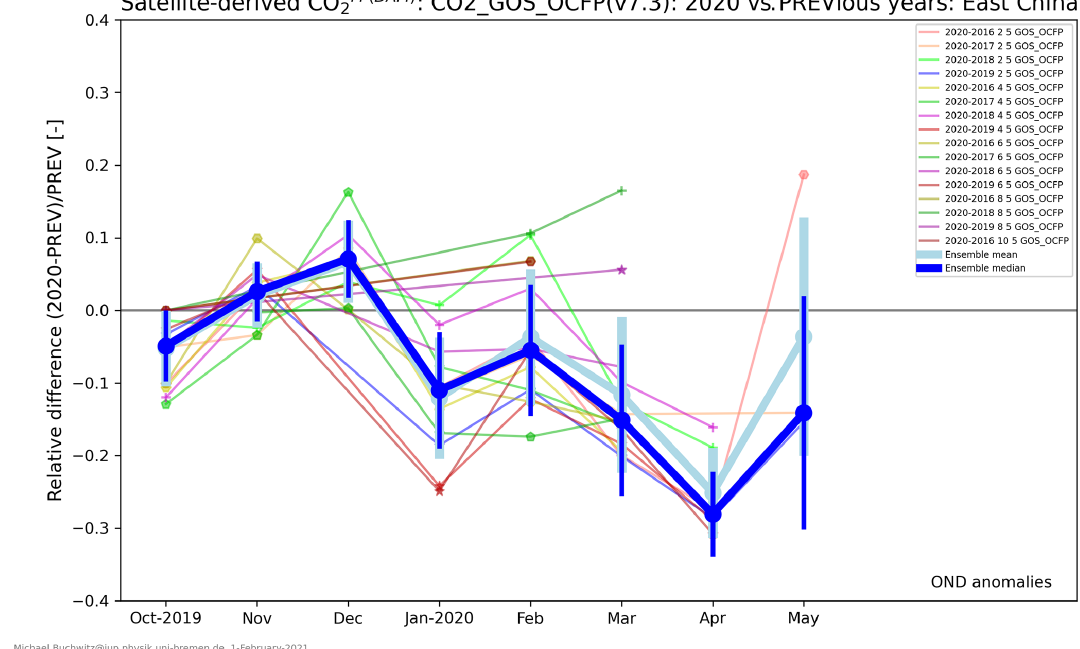
Figure 10. The same as Fig. 9 but for the product CO2_GOS_OCFP. Results are shown for several values of the required minimum number of observations per day: 2, 4, 6, 8, 10 and 15. The required minimum number of days per month is 5.